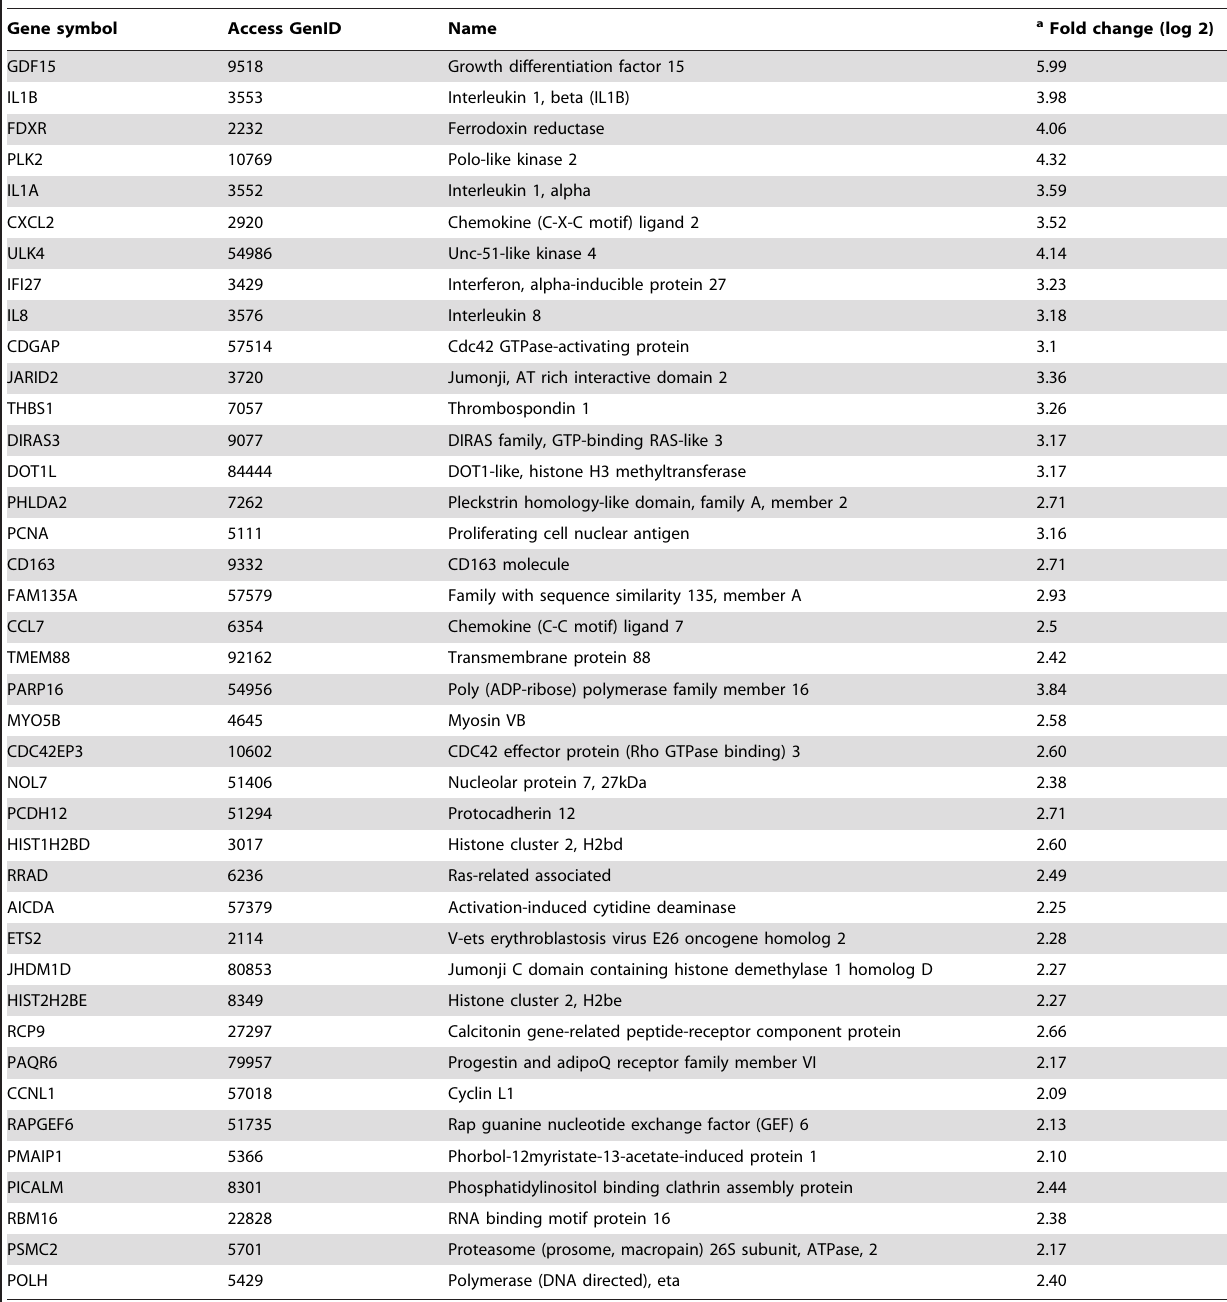
Table 1. Upregulated genes in UV irradiated Dcs vs non irradiated DCs.